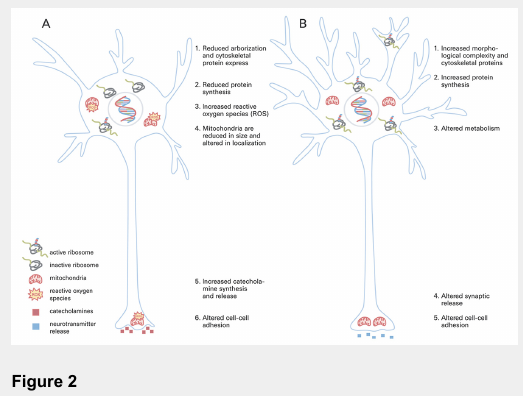
Figure 2 Schematic representation of reported changes to neurons in schizophrenia (A) and following antipsychotic treatment (B). Organelles are drawn to